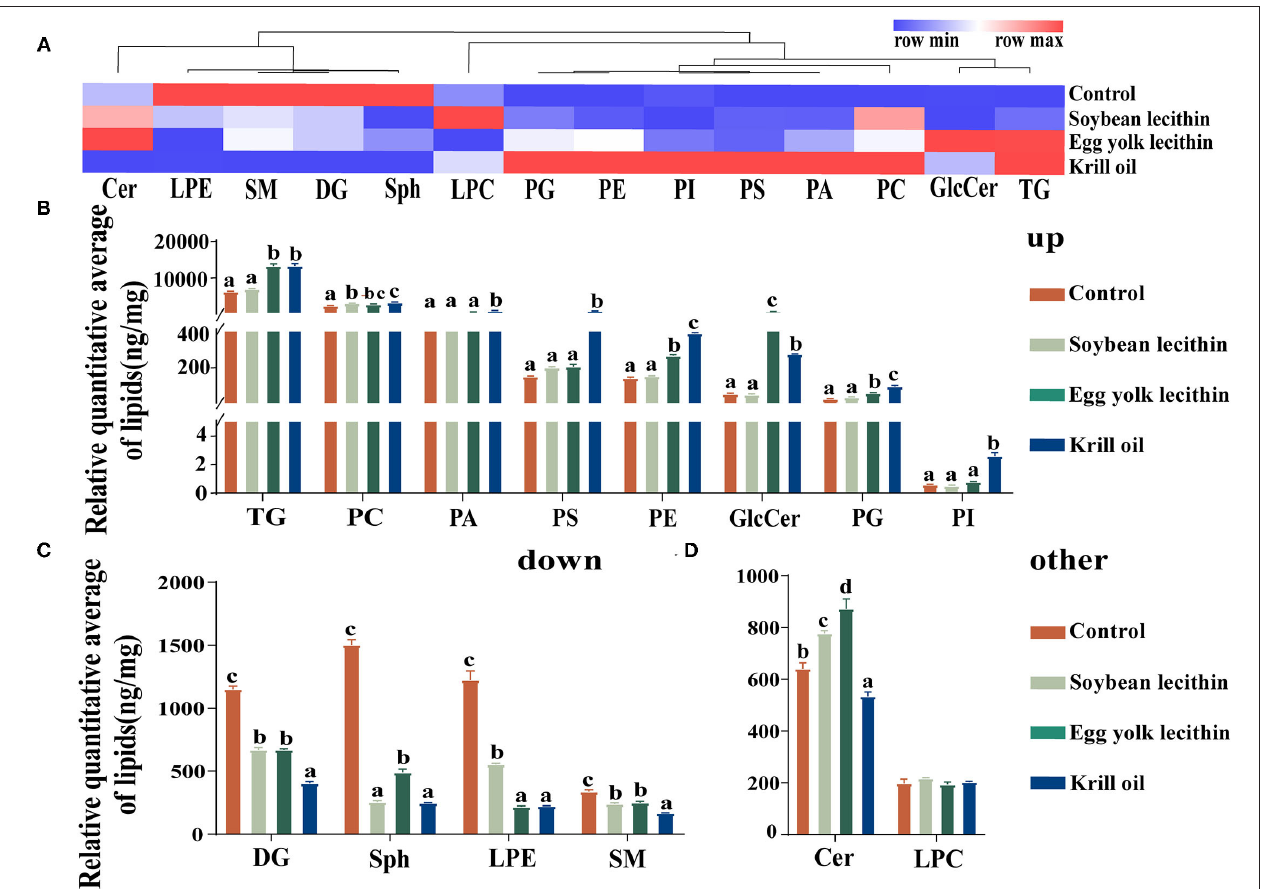
FIGURE 7 | Analysis of lipid differences in ovary. (A) Hierarchical cluster analysis of the sum of sublipids in each group. (B) Differential analysis of the sum of upregulated sublipids in each group. (C) Differential analysis of the sum of downregulated sublipids in each group. (D) Differential analysis of the sum of the other sublipids in each group. The values are the mean ± standard errors ( n = 4). Bars with different superscripts are significantly different ( p < 0.05, single factor analysis of variance and Duncan’s